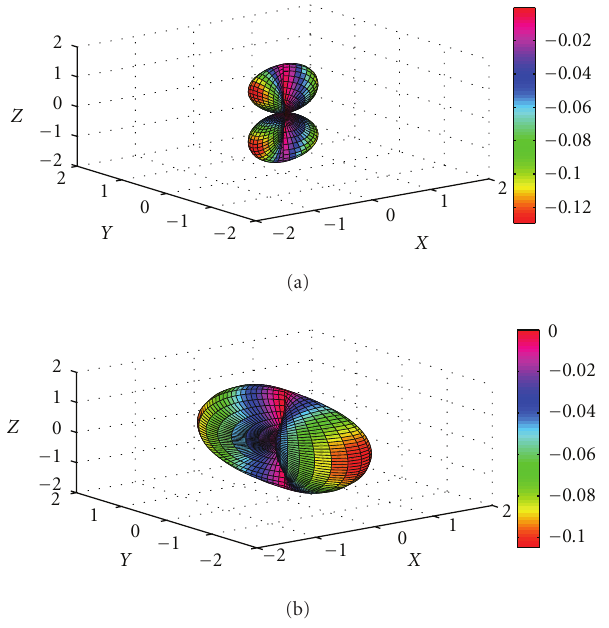
Figure 4: Gain patterns of half-wavelength dipole antenna with inclination angle of π / 2: (a) G ( v ) ( θ , φ ), and (b) G ( h ) ( θ , φ ).